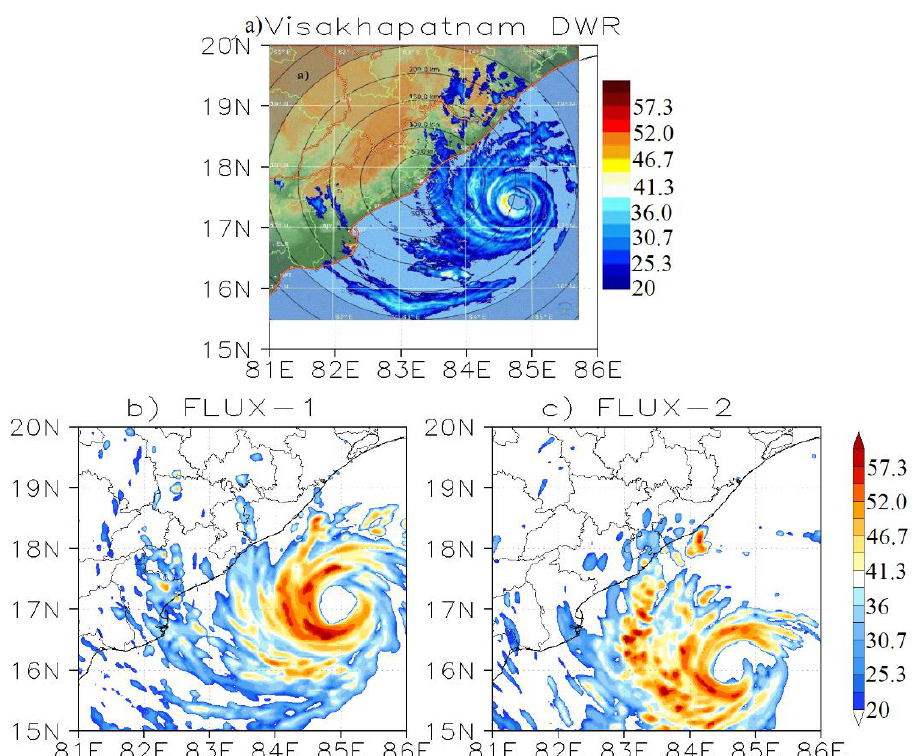
Figure 10. Maximum reflectivity (in dBZ; x -axis shows longitude and y -axis shows latitude) at 1130 UTC on 2 May 2019 obtained from ( a ) Visakhapatnam DWR, ( b ) the FLUX-1, and ( c ) the FLUX-2 experiment.